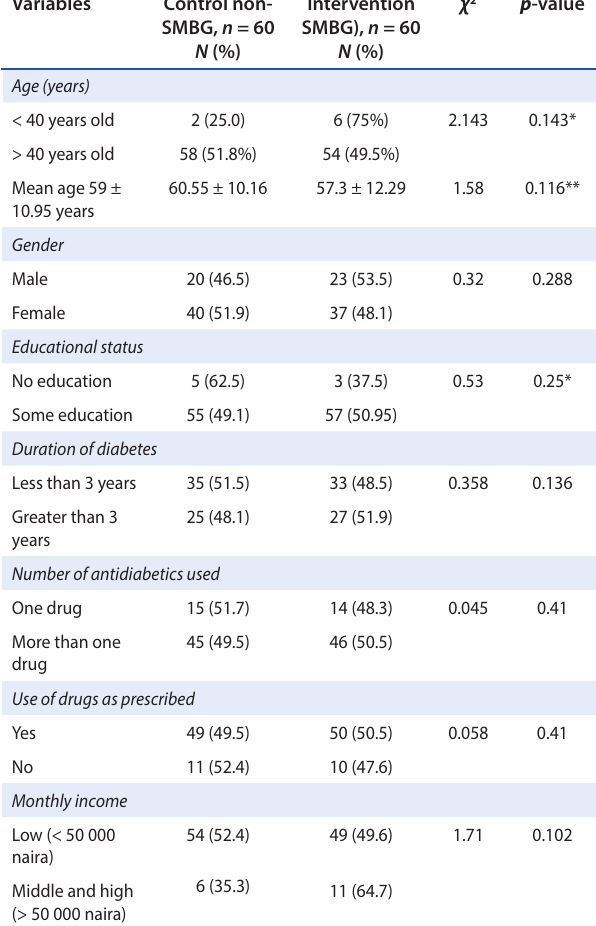
Note: N = 90. *Fisher’s exact test;